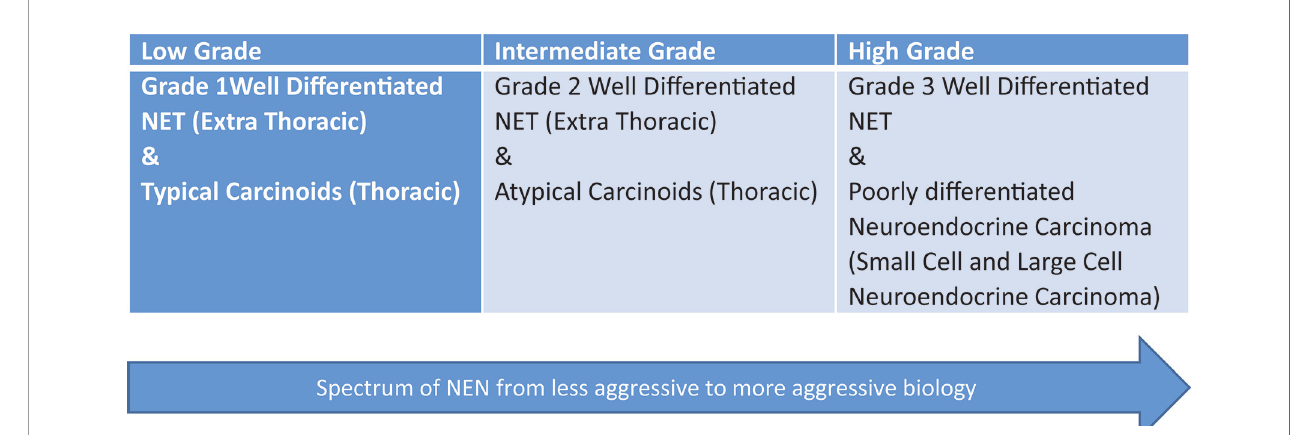
FIGURE 1 | Spectrum of neuroendocrine neoplasms (NEN). This graphic demonstrates the spectrum of neuroendocrine tumors from low grade to high grade.